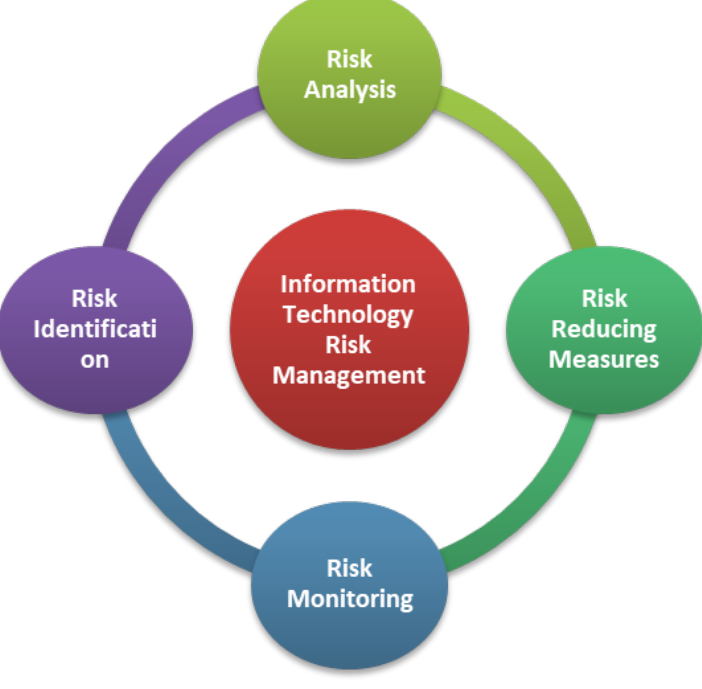
Figure 2. IT Risk Controls.